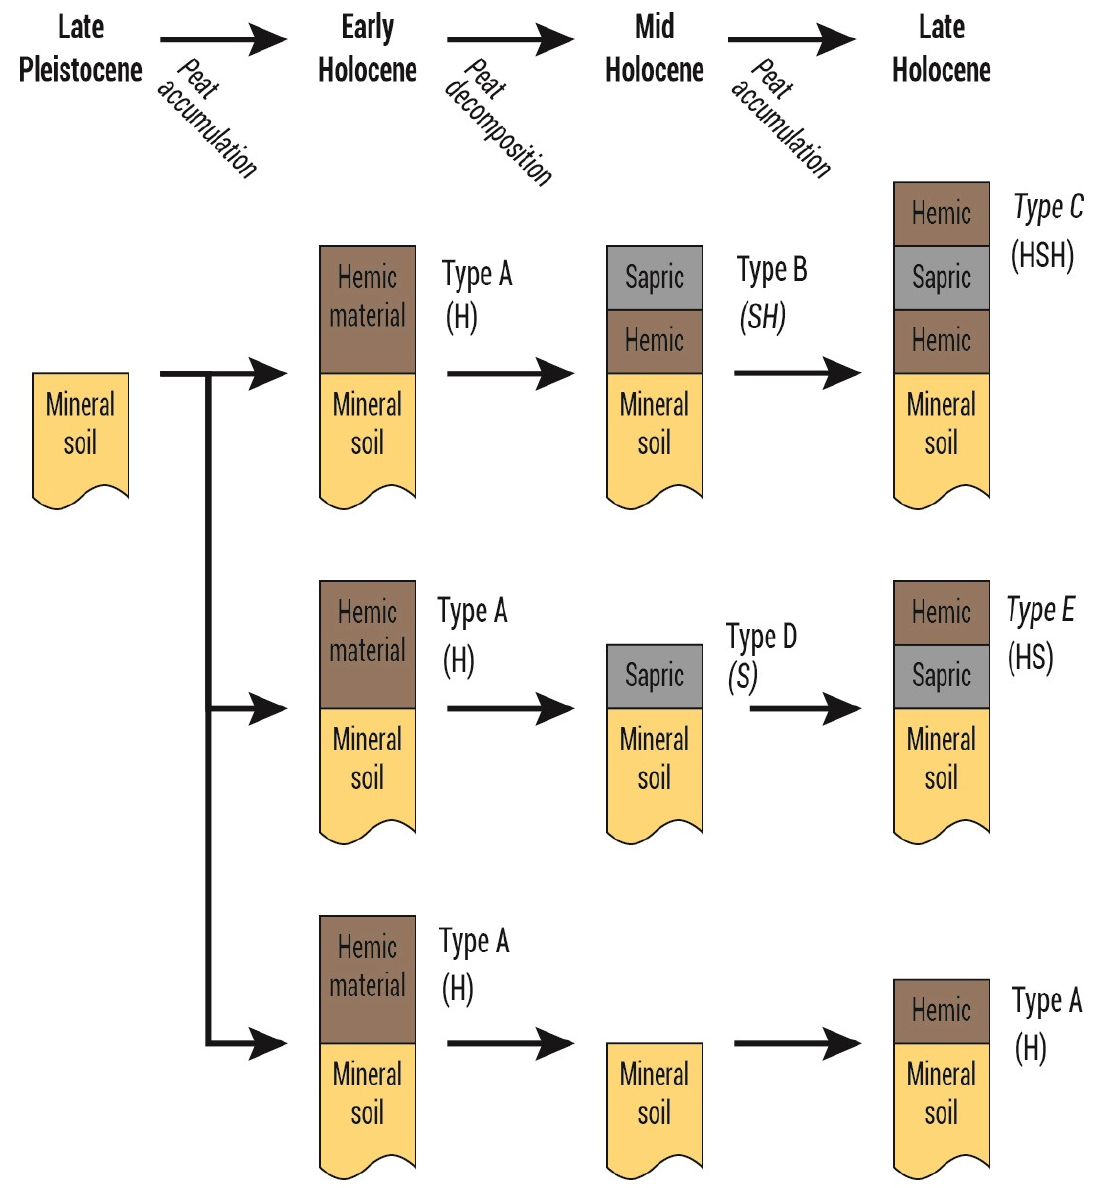
Figure 3. Possible development pathways for the five profiles types amongst CVNWR organic soil cores. Type B soil profiles (Figure 5) had a catotelm sequence of a sapric horizon underlain by a hemic horizon (SH). This horizonation occurred in four of the five peatlands (Table 2 Type A soil profiles (Figure 4) had a catotelm comprised entirely of hemic soil hori- zons (H). This horizonation occurred in four of the five peatlands (Table 2 and Figure 2). Of these 10 soil profiles, two had radiocarbon dates and none had laboratory data. Se- quential radiocarbon dates in Core 4.02 (Figure 4) and a basal peat date in Core 4.09, show that these Type A (H) profiles had basal peat dates of 4600 cal yr BP and 4900 cal yr BP, respectively. The late Northgrippian peat initiation in these two Type A (H) soil profiles (Figure